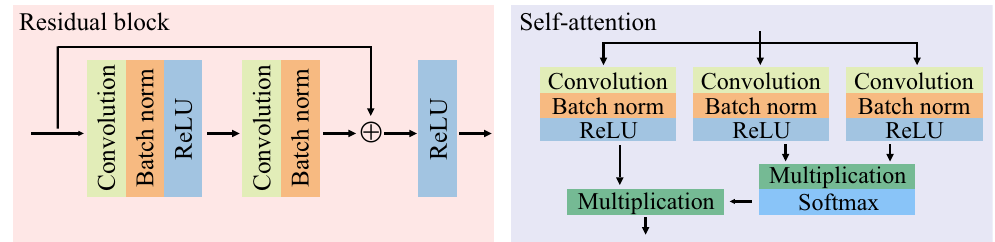
Figure 3. Structures of the residual block and the self-attention module. ⊕ represents the residual connection. ReLU represents the rectified linear